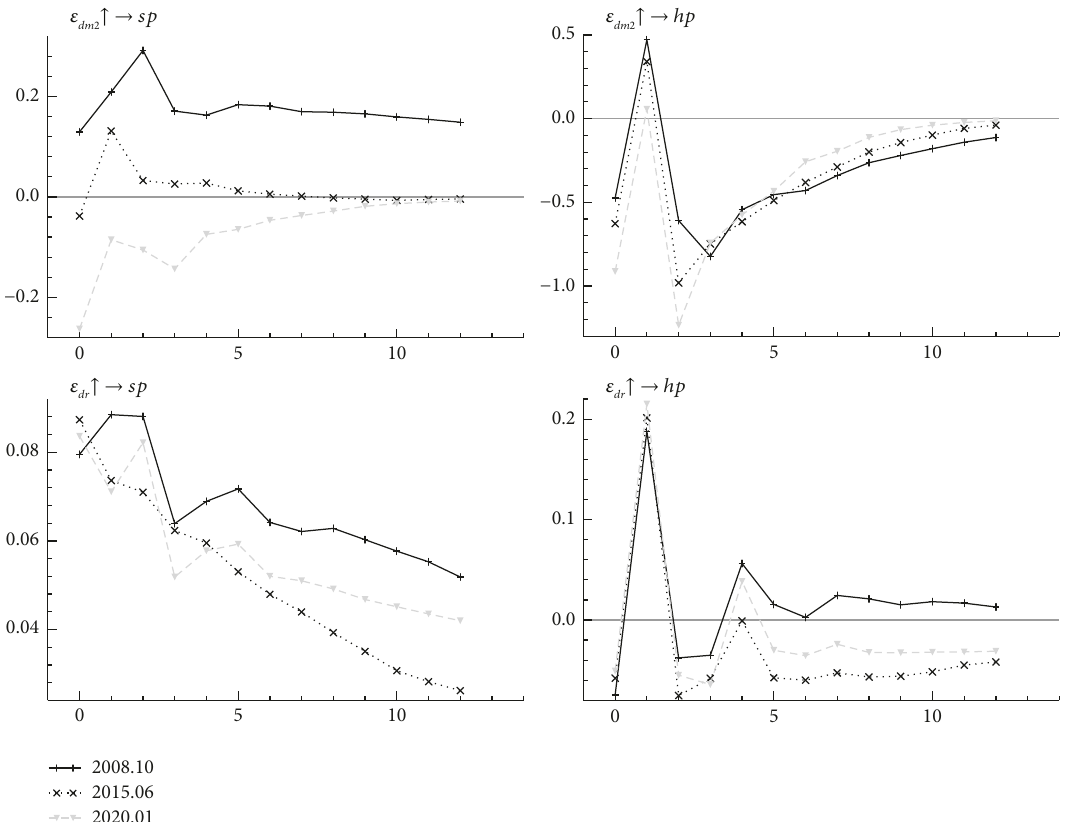
Figure 12: Impulse responses of monetary policy to asset price volatility at different time points.